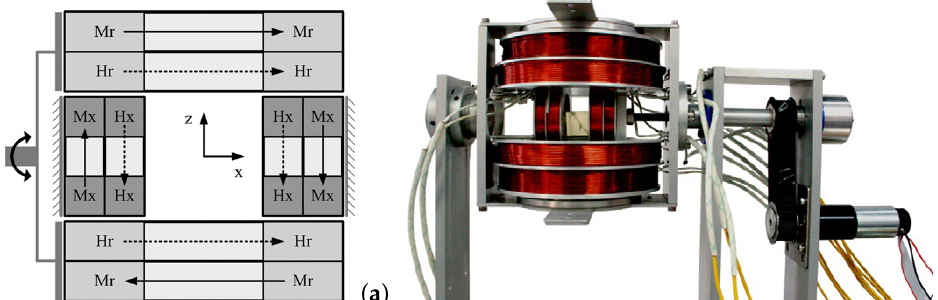
Figure 14. 2H2Mr EMA platform developed by Jeong et al. [61]: ( a ) scheme of the concept; and ( b ) a photograph of the built system.